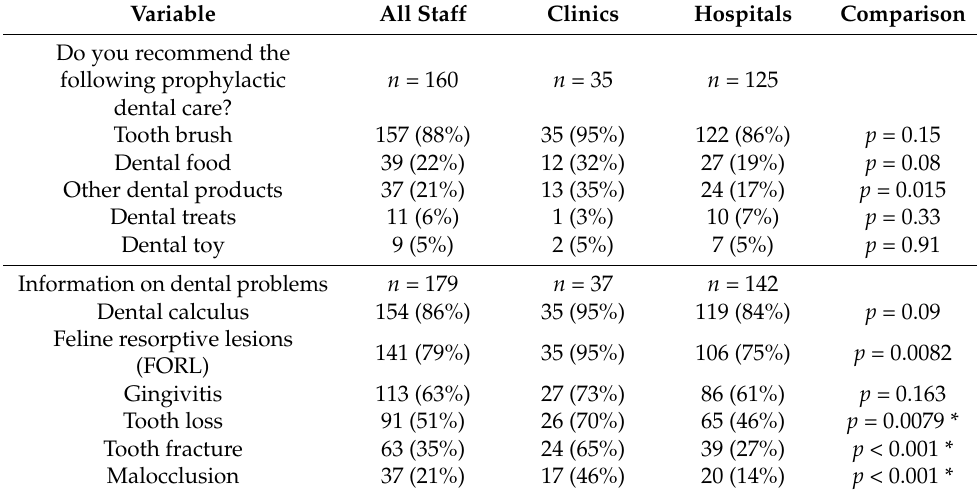
Table 7. Veterinary care staff responses regarding type of prophylactic care advice and information on signs of dental disease in cats to cat owners. The p -value for statistical significance was adjusted using the Bonferroni correction to avoid incorrect significance testing results due to multiple testing ( p -value for statistical significance = 0.05/5 = 0.01 and 0.05/6 = 0.008, respectively). * indicates statistically significant difference between types of veterinary facility